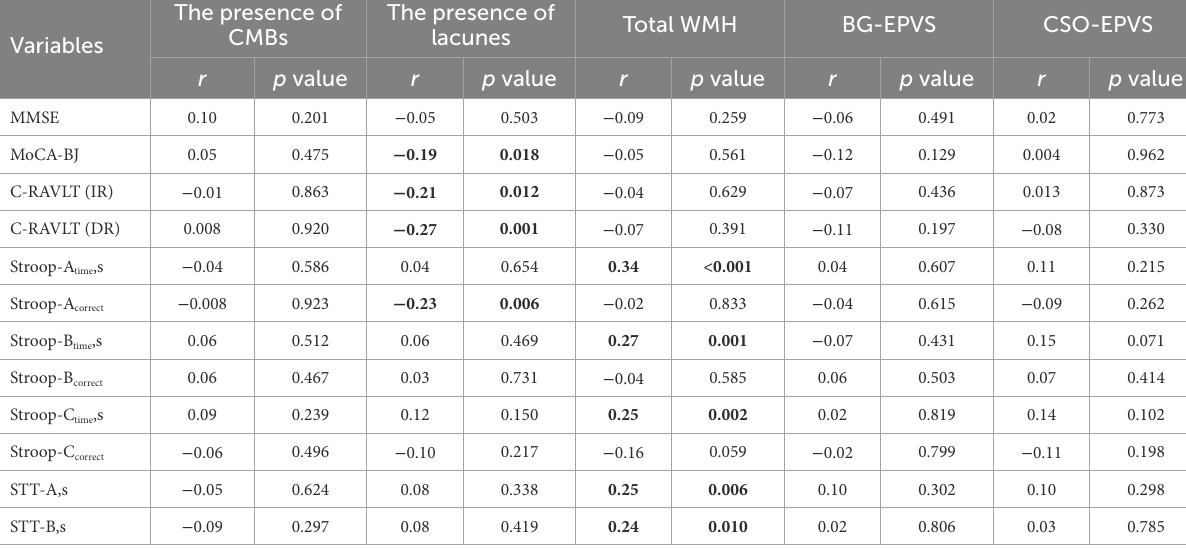
TABLE 2 Univariate analysis between SVD imaging markers and standardized cognitive measures.